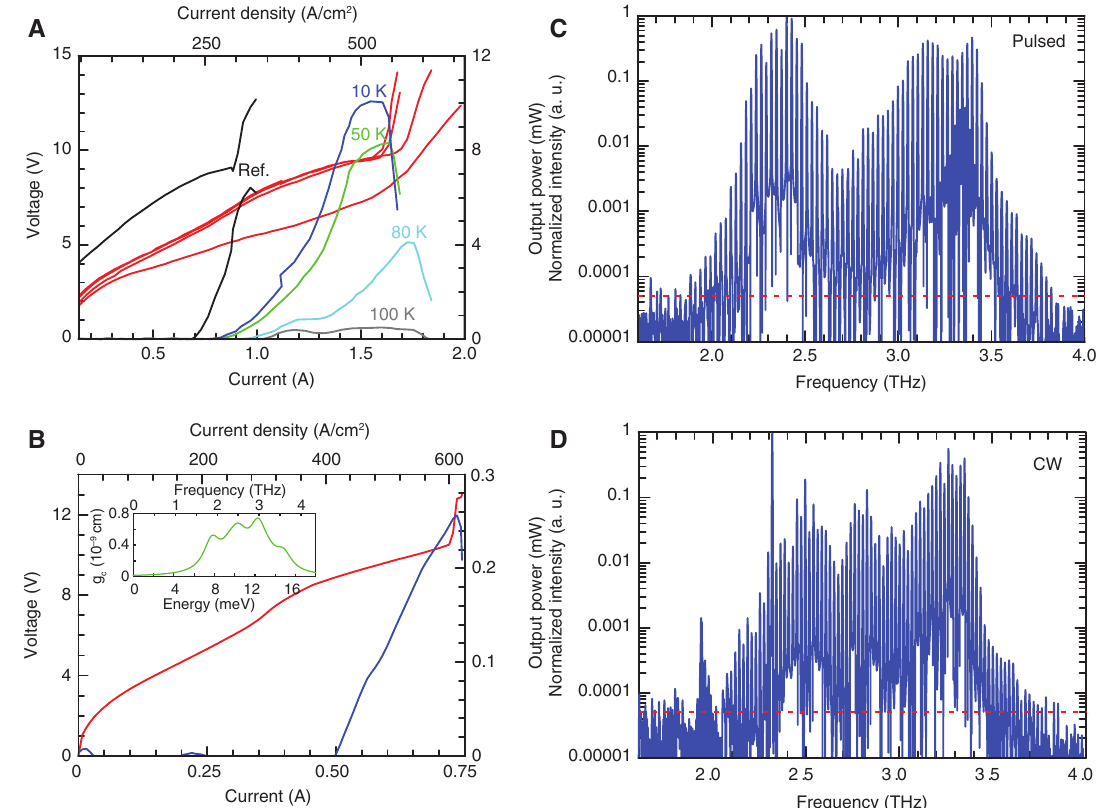
Figure 1: Laser characteristics: (A) Light-current and current-voltage characteristics for a 2 mm × 150 μ m wet-etched laser in pulsed operation at different temperatures. To emphasize the improvements, a reference measurement of a laser with the same dimensions (black curves) based on the design reported in Ref. [8] is shown. The measurements were performed in pulsed operation with 10% duty cycle (5% for the 100 K measurement). The optical power was measured with a calibrated powermeter (TK instruments). (B) Light-current and current-voltage characteristics for a 2 mm × 60 μ m dry-etched laser in CW operation at 20 K. The power was measured with a calibrated powermeter (Ophir:3A-P-THz). The inset shows the calculated gain cross-section g of the reported laser design. (C) Optical spectrum of a c 1.5 mm × 150 μ m wet-etched laser in pulsed operation (20% duty cycle) at 20 K. (D) Optical spectrum of a 1.8 mm × 60 μ m dry-etched laser in CW operation at 21 K. The spectra in (C) and (D) were measured using a commercial vacuum FTIR (Bruker v80) using the internal room temperature deuterated triglycine sulfate detector. The red dashed lines indicate roughly the noise floor of the